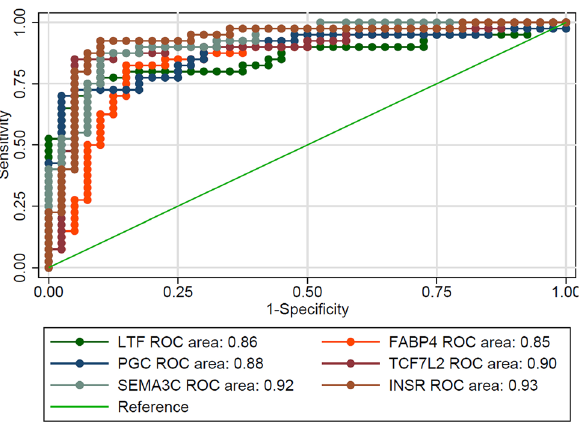
Figure 7. The ROC curve of each key